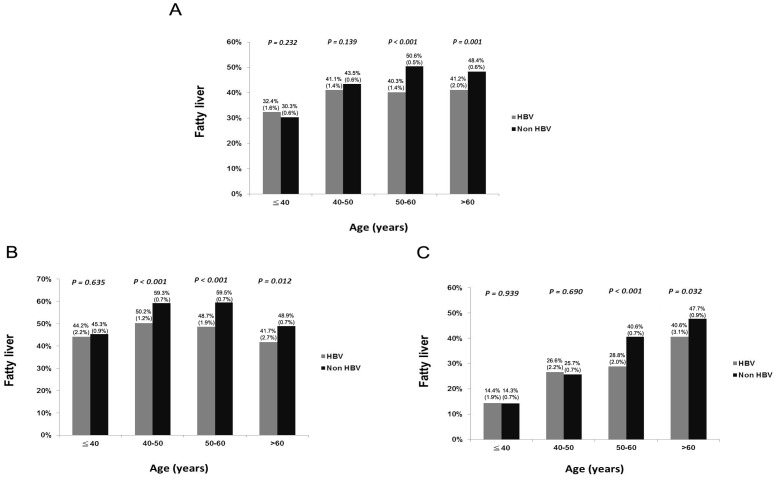
Age distribution of fatty liver stratified by HBV status (A) all subjects, (B) males and (C) females.The prevalence rates of fatty liver in all subgroups are expressed as prevalence rate (standard error).